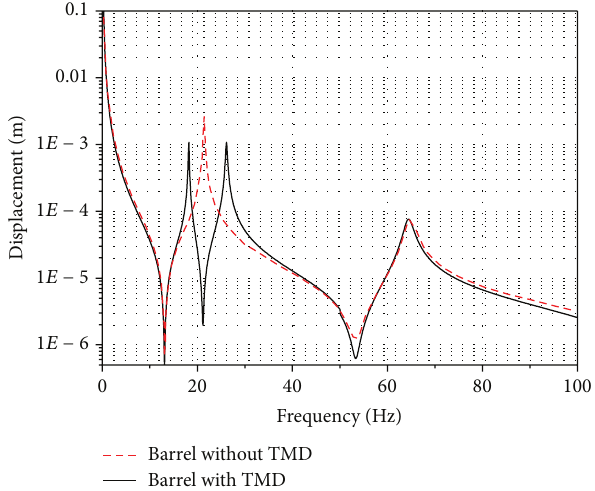
Figure 7: Frequency response function of transverse bending dis-